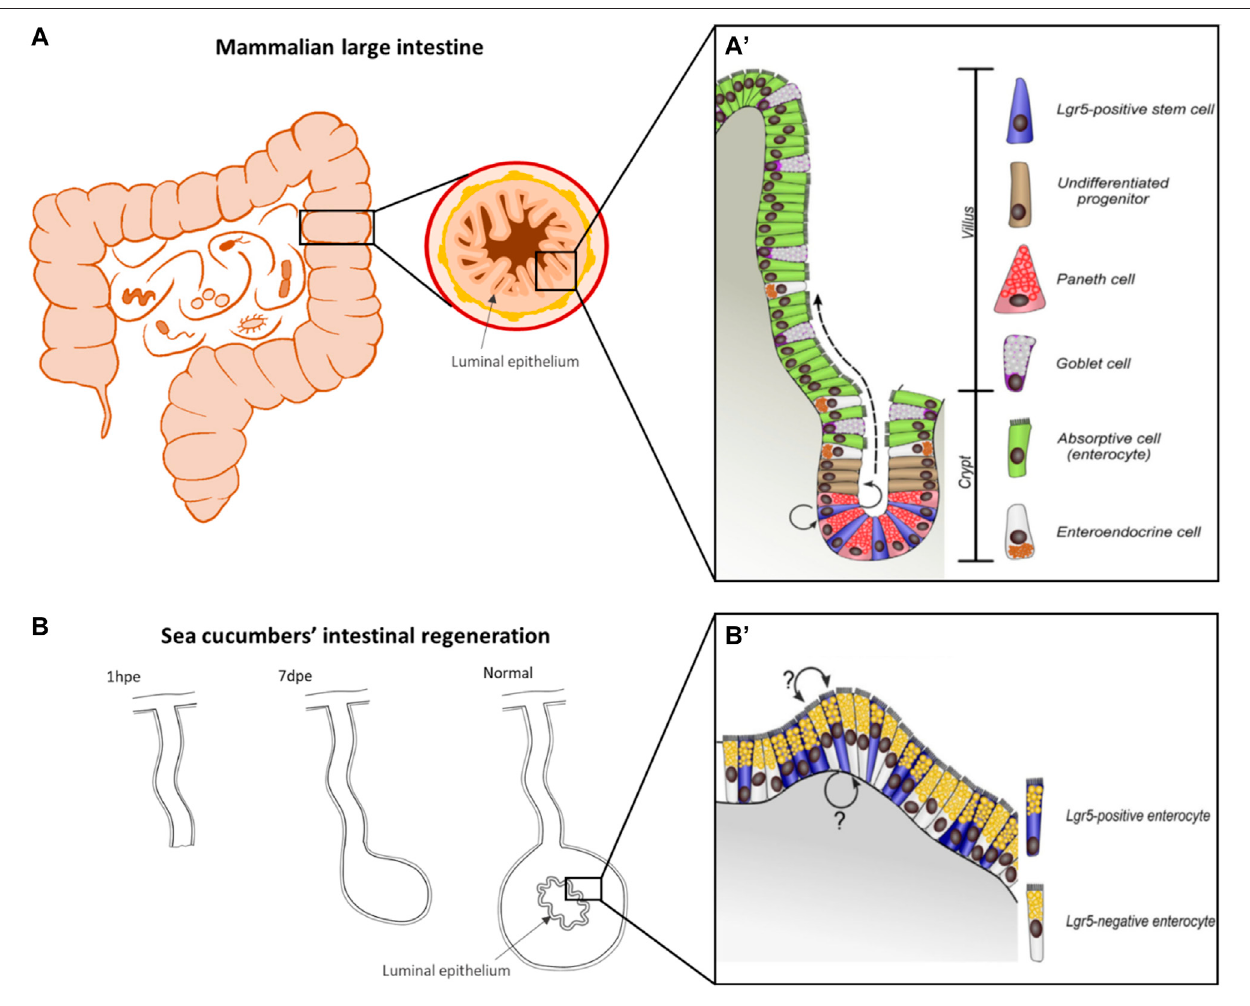
FIGURE 3 | Comparison of mammalian and holothurian intestinal epithelium anatomy and renewal. Representative organization of the luminal epithelium of mammal intestine (A) and the mucosal epithelium in the digestive tube of sea cucumbers (B) , highlighting the difference in cell renewal mechanisms. (A) In mammals, Lgr5-positive intestinal stemcells are localized at the bottom ofthe crypt, which self-renew and produce dividing transit-amplifyingprogenitors (arrows), which gradually migrate apically and form the villus (dashed arrow), where are localized the specialized cells. Paneth cells (which appear to be unique in mammals) are the only differentiatedcelltypethatremainsinthestemcellniche. (B) Inthedigestiveepitheliumofechinoderms,thespatialorganizationofmammalsisnotpresent,insteadLgr5- positive cells are interspersed among Lgr5-negative or differentiated cells, but the lineage of these cells is not well understood. (A 9 ,B 9 ) were retrieved from Mashanov et al., 2014 and modi fi ed by LD-D, (A,B) are drawings by the authors of this article (AR-V and LD-D, respectively) for the purposes of this comparison.